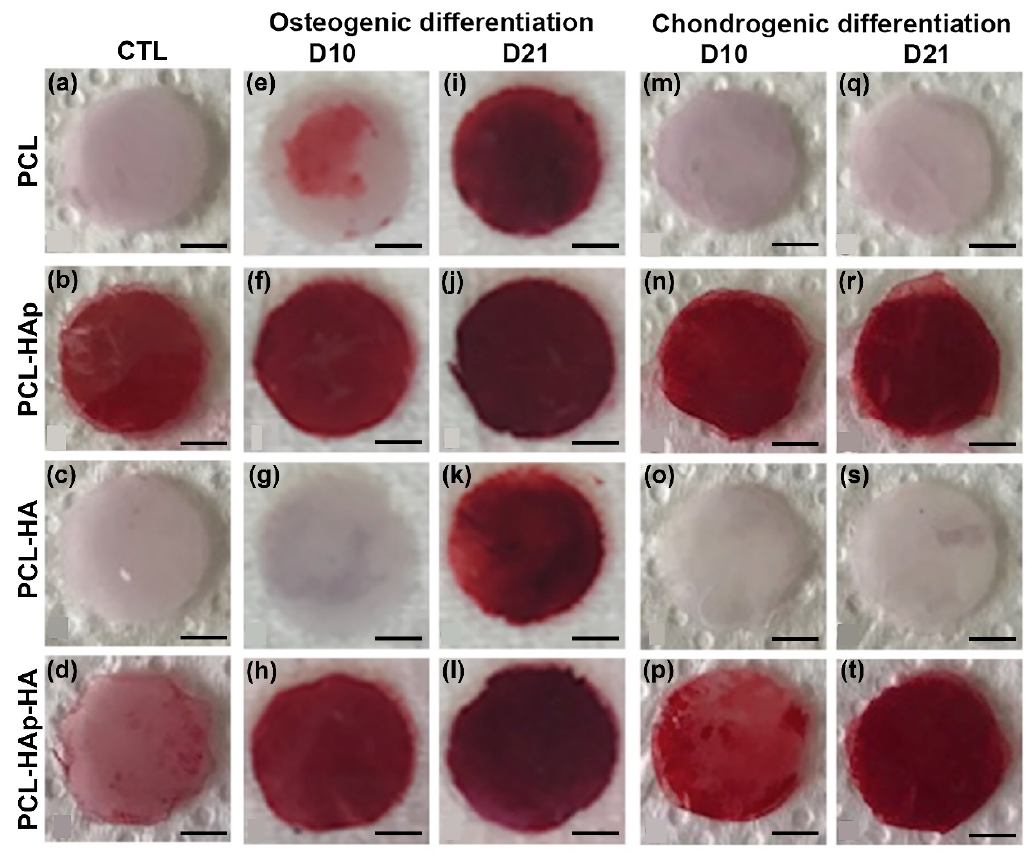
Figure 5. Staining with Alizarin Red S after 10 days ( e – h ), ( m – p ) and 21 days ( i – l ), ( q – t ) of culture of hBM-MSCs on the four types of scaffolds in an osteogenic medium ( e – l ) and a chondrogenic medium ( mt ). Control cell-free membranes were also stained ( a – d ). Bars represent 2 mm.